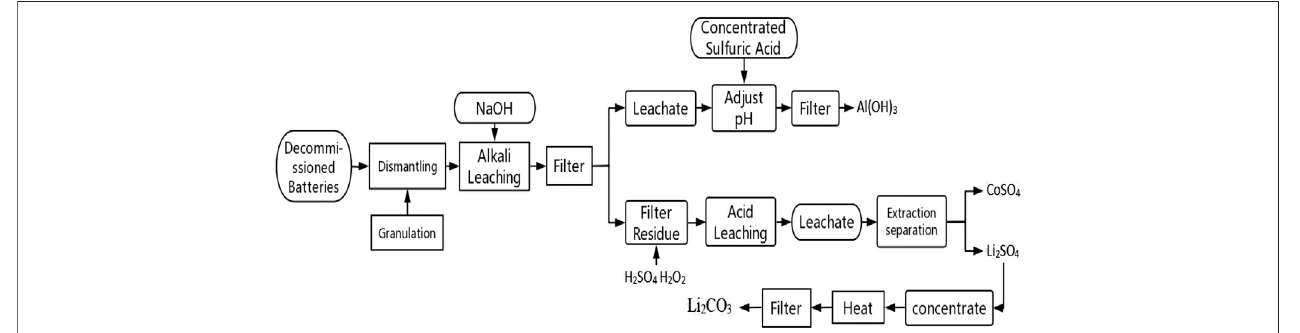
FIGURE 2 | Flow chart of lithium battery recovery in hydrometallurgy